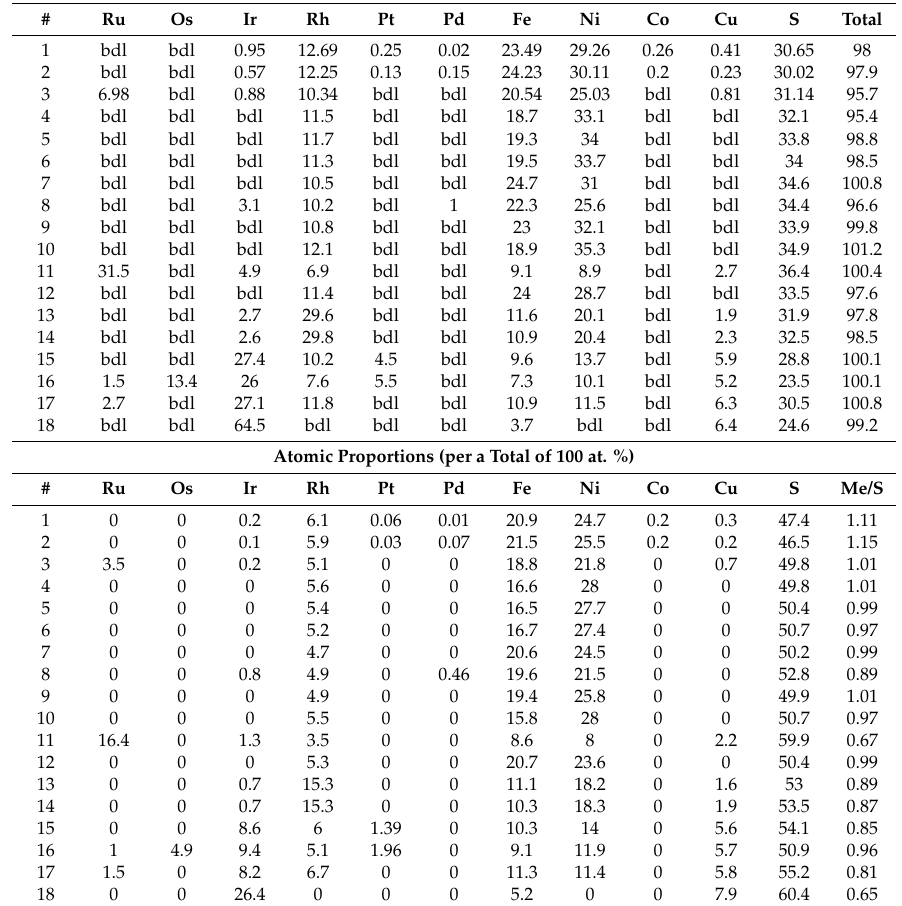
Table 8. Compositions of monosulfide- and pentlandite-type inclusions hosted by grains of PGE alloy minerals in the Sisim placer zone, Eastern Sayans.